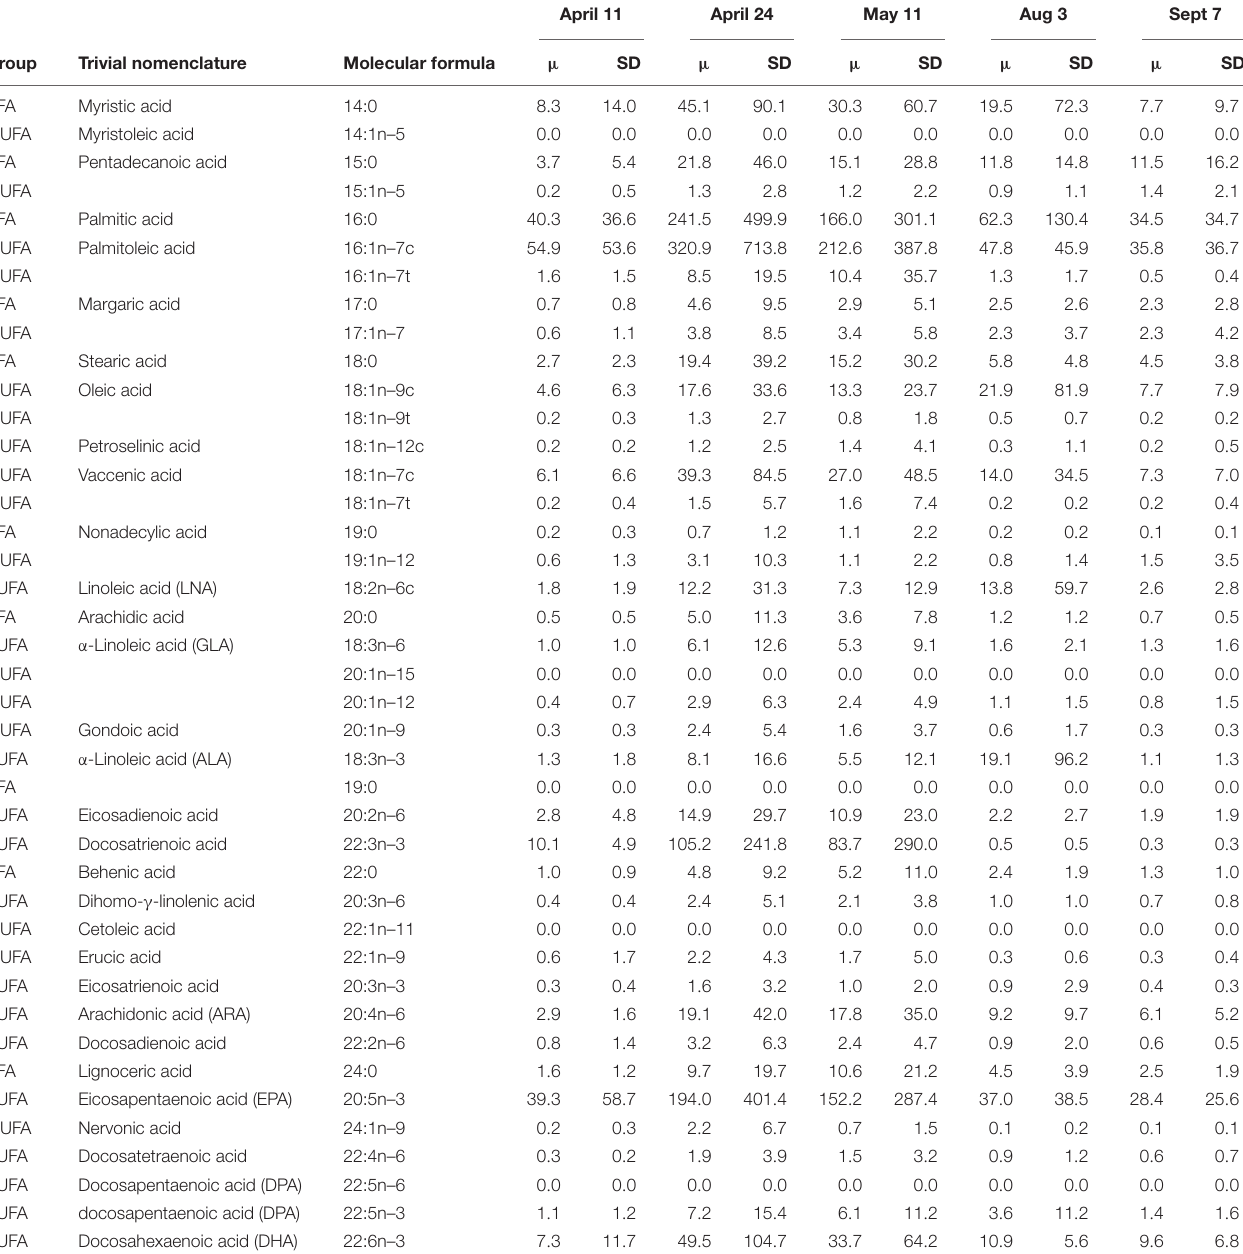
TABLE 2 | Summary of fatty acid